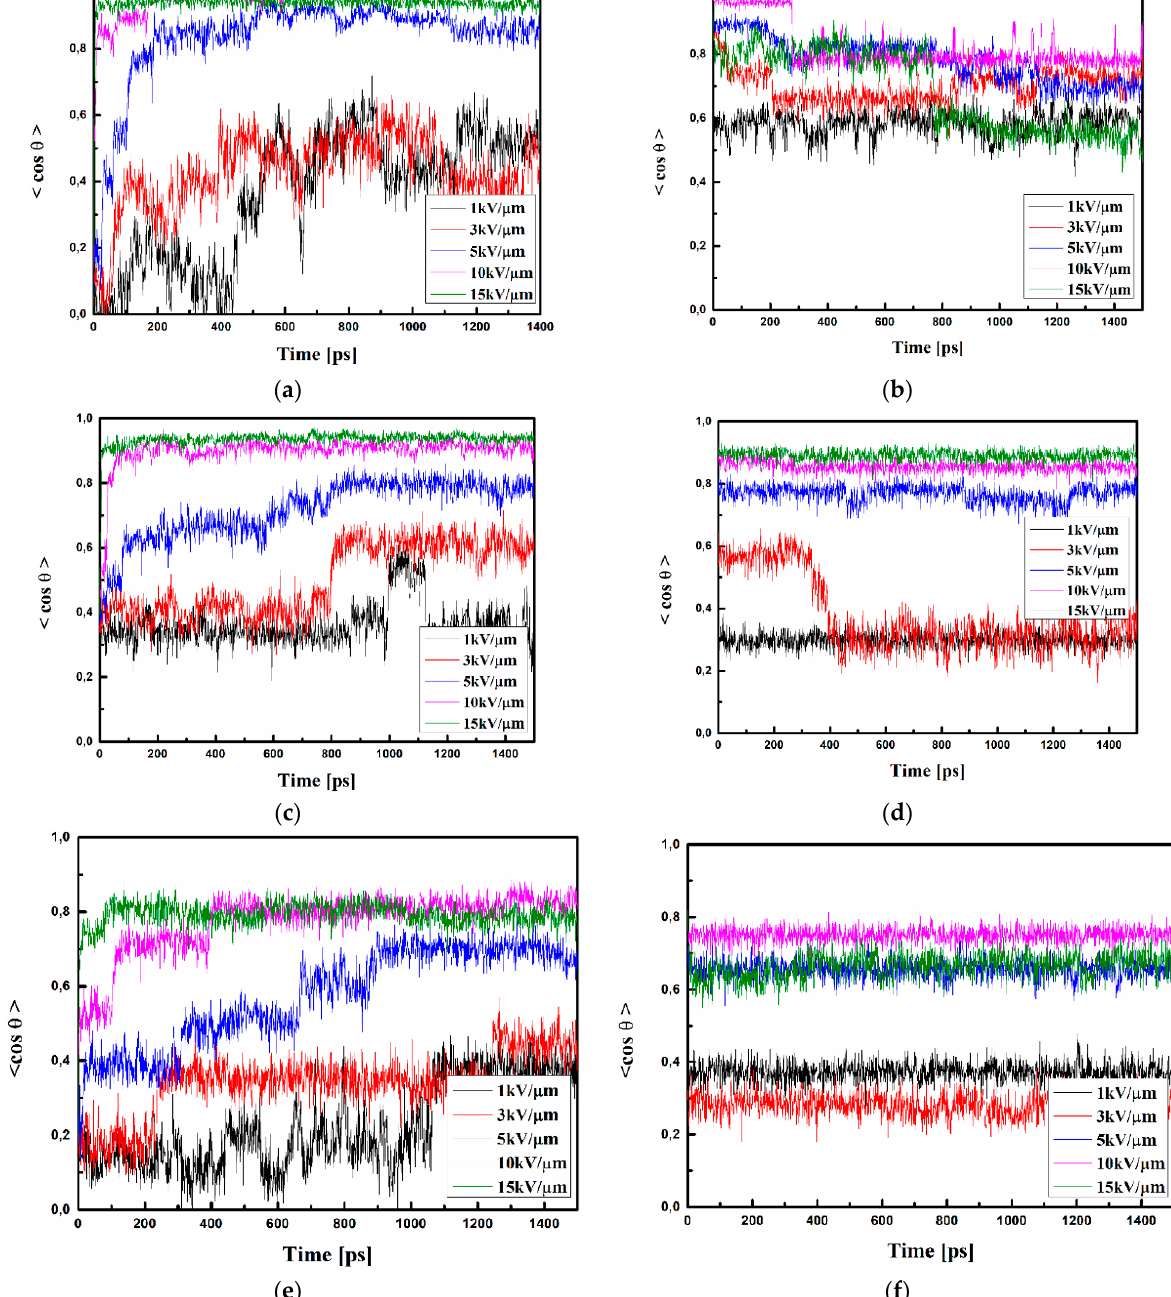
Figure 9. Changes in the value of the order parameter < cos θ ( t ) > versus the time of simulation and applied external electric field calculated by the MD technique for the A / PVK ( a , b ), B / PVK ( c , d ), and C / PVK ( e , f ) composites in the volumetric form at the temperature of 500 K ( a , c , e ) and glassy state (300 K) after the simulated annealing ( b , d , f ).